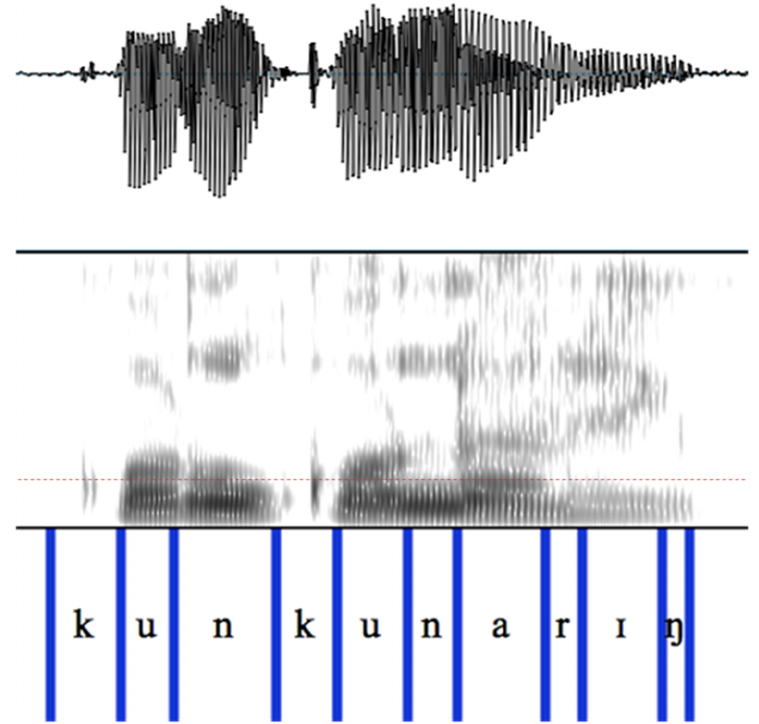
Figure 11. Example of a shortened nasal with an elided vowel by Older speaker UT (kunkunari- ŋ u ‘sleep- PST /slept’). (SW20190328-02-MonsterStory). Nasal consonants were also regularly (phonetically) prestopped; this was observed in various contexts including the utterance-final past tense suffixes. Older speakers pro- duced 15% of their past tense suffix nasal consonants with prestopping, while Younger speakers prestopped 8% of tokens. Prestopping was observed with fully produced nasals and those where the place of articulation was changed. Since this does not represent a lenition of the consonant, we will not examine it further here. 3.3. Suffix Deletion: When Neither Nasal Nor Vowel Are Produced Sometimes, speakers of both age groups fully elided the suffix, producing neither the nasal nor the vowel segment of the past tense suffix. This occurred in 9% of Older speaker tokens and 8% of Younger speaker tokens. Speakers elided the entire suffix with verbs of all lengths, including monosyllabic verb roots u- ŋ u ‘give- PST ’ and ɲ a- ŋ u ‘see- PST ’; this was unexpected given Pitjantjatjara has been analyzed as having a bimoraic word minimum (Goddard 1985, p. 13). One of the questions raised in Section 1.3 was whether there are any remaining pho- netic traces of the elided segments that may lead speakers to perceive suffixes as being present. When the syllable was elided, there were detectable traces on the final vowel of the verb stem 50% of the time for Older speakers, and 73% of the time for Younger speak- ers. In some cases, only nasalization of the final stem vowel was detectable (8% for Older speakers and 9% for Younger). In most cases where there was some trace of the elided